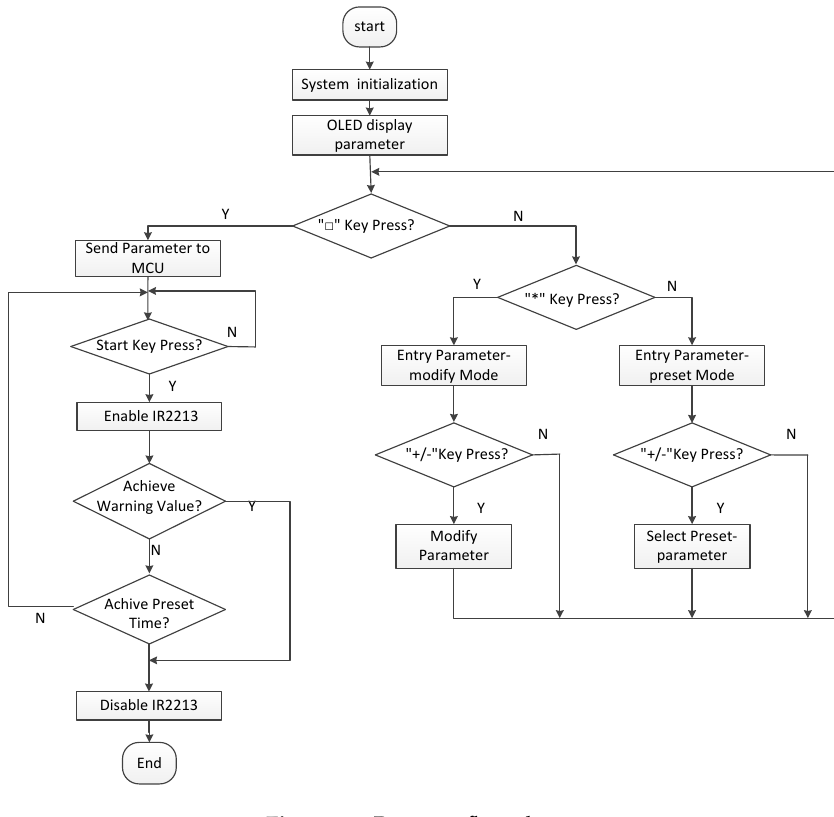
Figure 13. Program flow chart.